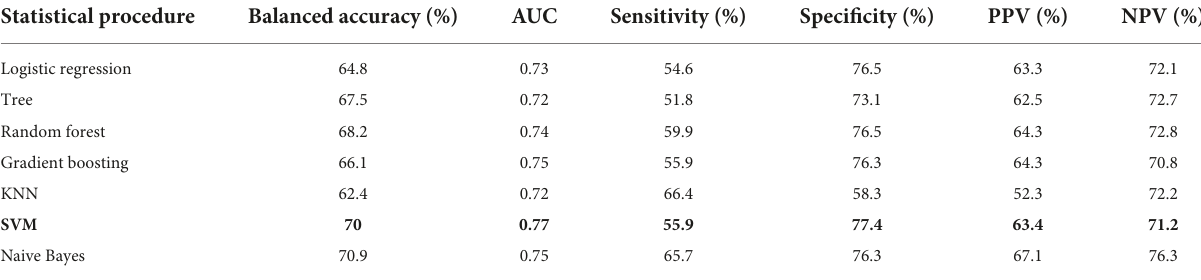
TABLE 2 Machine learning models and performance in nested